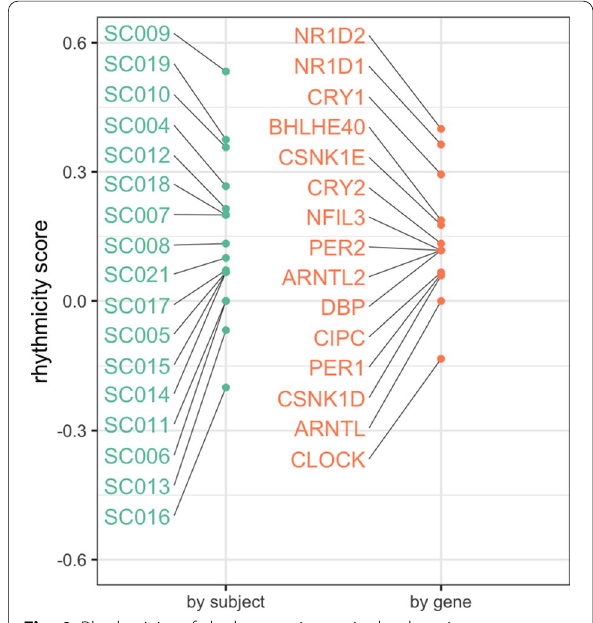
Fig. 4 Rhythmicity of clock genes in septic shock patients grouped by patient and clock gene. The rhythmicity score takes a value between 1 and 1, with a value of 1 and 1 representing − − rhythmicity and arrhythmicity, respectively. The scores shown are aggregates of all clock genes in a subject (‘by subject’), or of all subjects for a particular clock gene (‘by gene’)